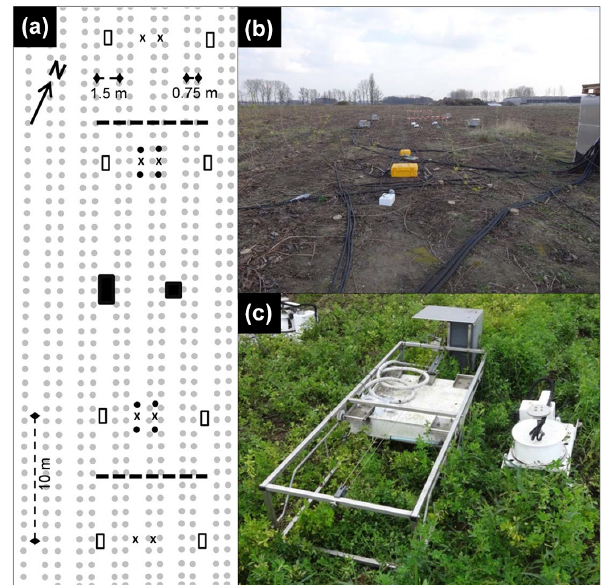
Figure 1. Schematic drawing of the field site (a) , view of the south- ern half of the field site on 25 March 2014 shortly after the harvest (b) , and size comparison of an AGPS chamber (left, chamber open) and a LI-8100A chamber (right, chamber closed) (c) . In (a) , the big black-filled rectangle shows the location of the housing for the Los- Gatos analysers and the AGPS multiplexer; the small black-filled rectangle indicates the location of the LI-8100A gas analyser and multiplexer; hollow rectangles represent AGPS chambers; black cir- cles represent LI-8100A chambers; crosses represent soil gas con- centration measurement nests; grey circles indicate the position of the poplars. The dashed black lines indicate the soil sampling tran-